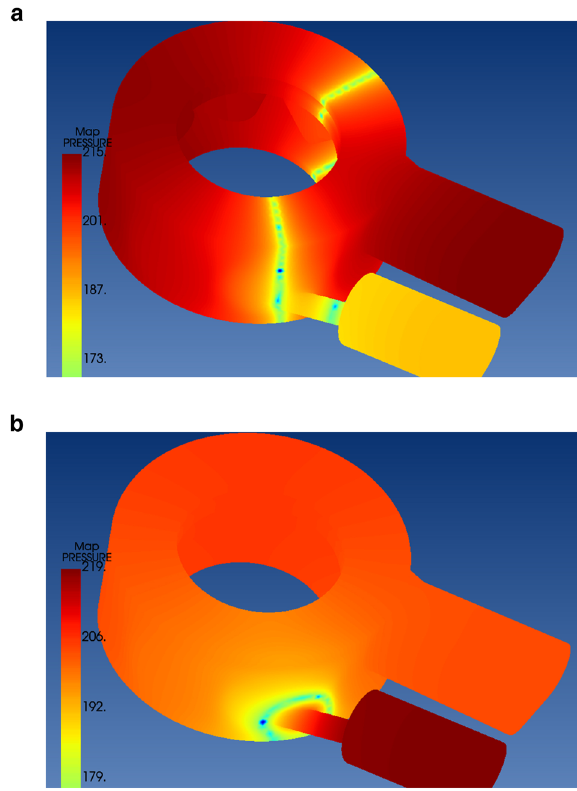
Fig. 7 Visualized mode shape calculation results of interior air layer. a fi rst mode and ( b ), second